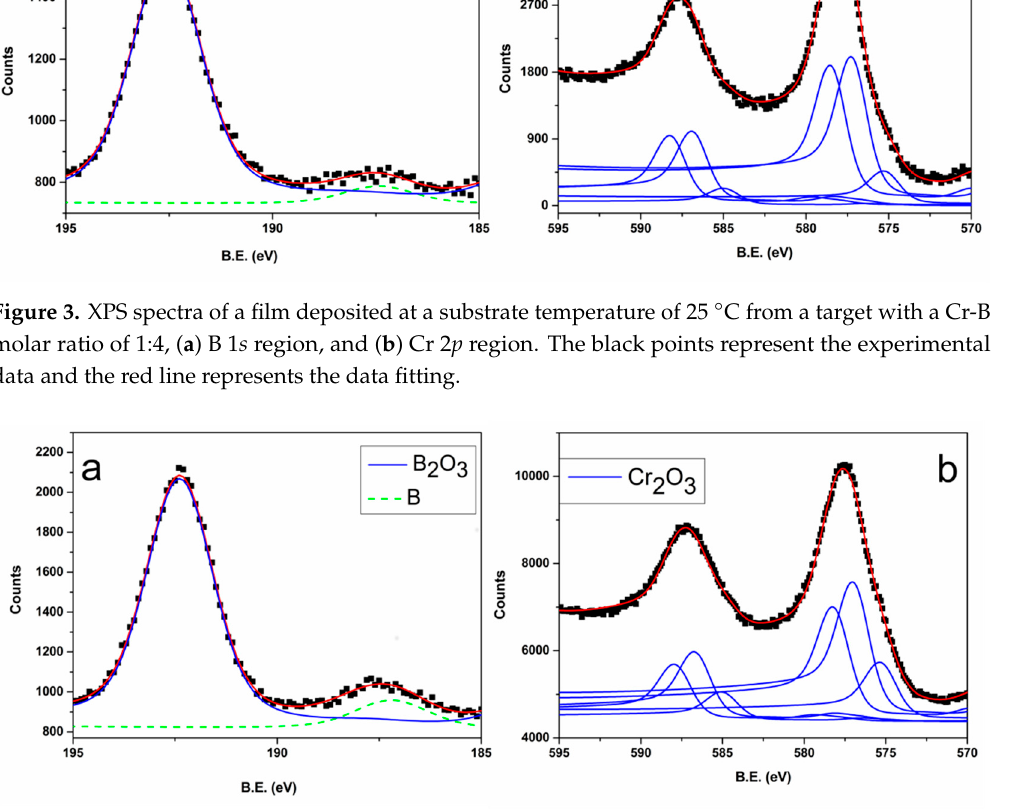
Figure 4. spectra of a film deposited at a substrate temperature of 300 °C from a target with a Cr–B molar ratio of 1:4, ( a ) B 1 s region, and ( b ) Cr 2 p region. The black points represent the experimental data and the red line represents the data fitting.